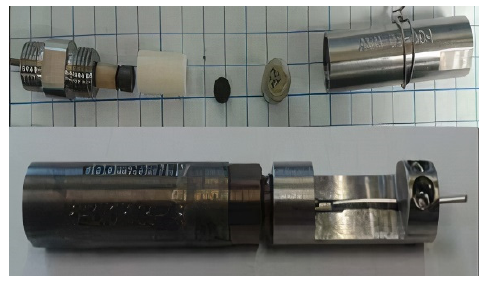
Figure 8. Photos of the test capsule components shown as a diagram in Figure 1 [14].